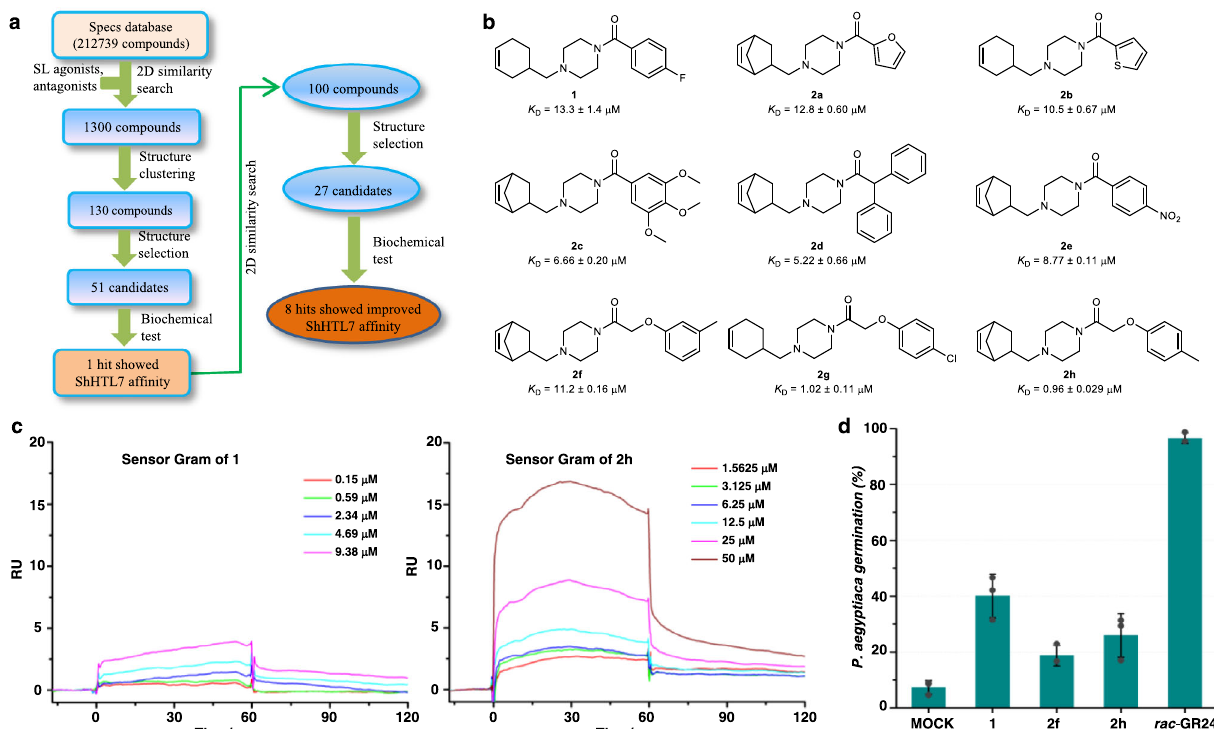
Fig. 1 The discovery of small molecules binding to ShHTL7 by virtual-screening approach. a A hierarchical 2D molecular fi ngerprints similarity- based virtual-screening strategy was performed: a database containing more than 210,000 compounds from Specs was screened by Accelrys Discovery Studio 2.5 (DS 2.5). Thirteen reported parasitic plant seed germination stimulants (Supplementary Fig. 1) were selected as representative search query molecules, 78 candidates were selected for ShHTL7 binding assay, which depended on their physicochemical properties and structural features, with nine hits found. b Chemical structures of nine hit compounds, the K D values were determined by SPR assay and the results are shown below each hit. c Representative fi gures of SPR sensorgrams of compounds 1 and 2h from three independent experiments. d Compounds 1 , 2f , 2h , and rac -GR24 induced the germination of P. aegyptiaca seeds at 10 μ M. Error bars mean standard error (SD, n = 3 biologically independent